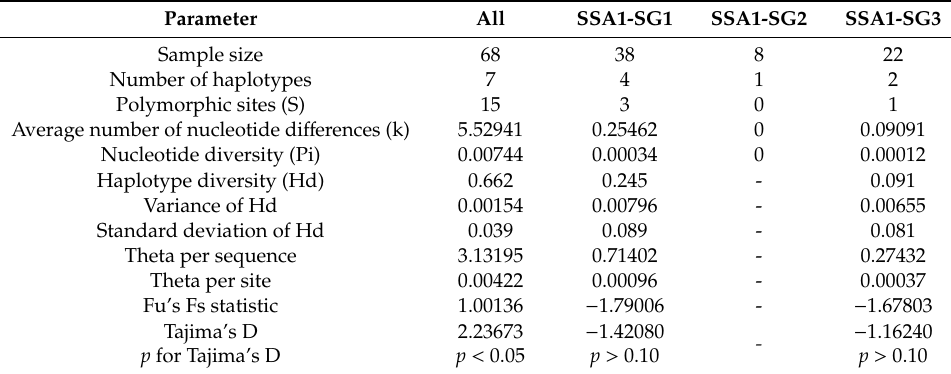
Table 3. Population genetic analysis of Bemisia tabaci groups from Zambia: 2013 and 2015. Parameter